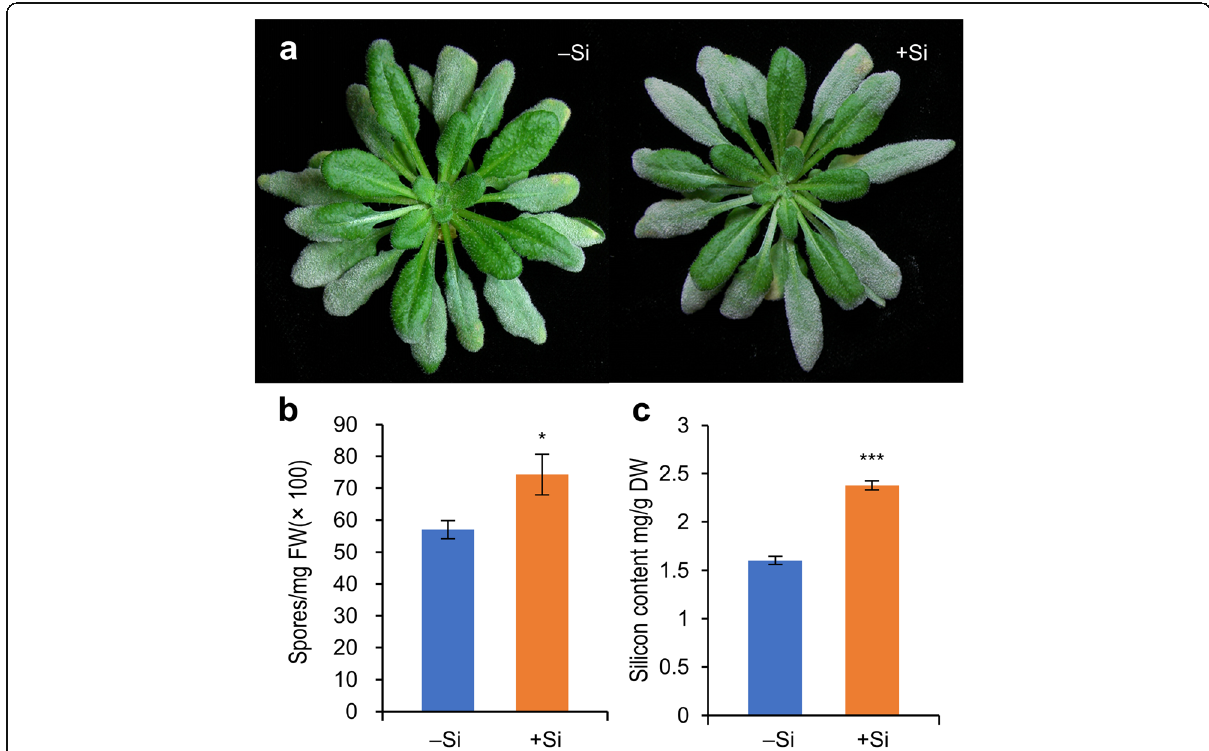
Fig. 1 Arabidopsis plants containing very low leaf Si exhibit enhanced basal resistance against an adapted powdery mildew pathogen. a Infection phenotypes of representative Arabidopsis Col-0 plants grown in perlite supplemented with 0 mM ( − Si) or 1.0 mM (+Si) silicon (See Methods for details). Seven-week-old plants were inoculated with G. cichoracearum (Gc) UCSC1. Photos were taken at 10 dpi. b Quantification of spore production in the infected leaves of the plants in (a) at 10 dpi. c Silicon content in leaves of Col-0 plants grown under conditions indicated in (a) before fungal infection. FW, fresh weight; DW, dry weight; Error bar indicates SE based on 4 replicates, and asterisks denote significant difference (Student t -test, * P < 0.05, *** P <